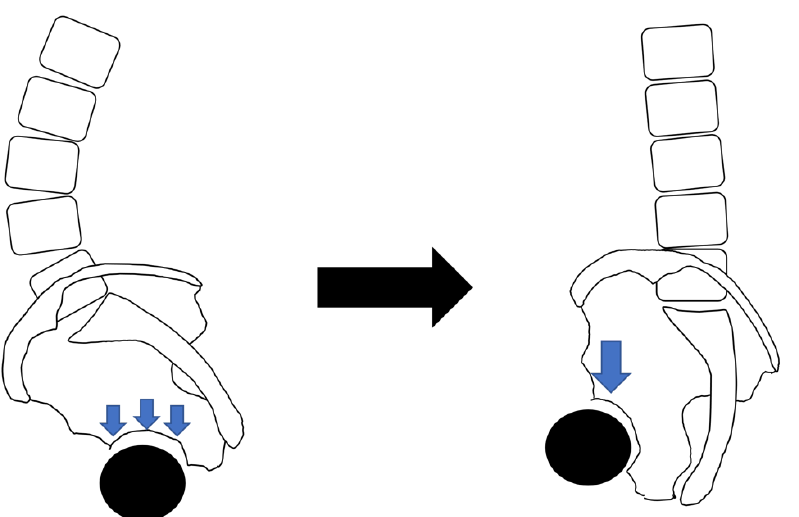
Figure 4. Stress concentration on the femoral head with greater PI, lumbar kyphosis, and posterior pelvic tilt. A case with greater PI, lumbar lordosis, and pelvic forward tilt ( left ) may have a relative decrease in anterior coverage of the acetabular head and increased abnormal stress on the head when the lumbar spine becomes kyphotic and when pelvis tilts posteriorly due to age-related degeneration ( right ).